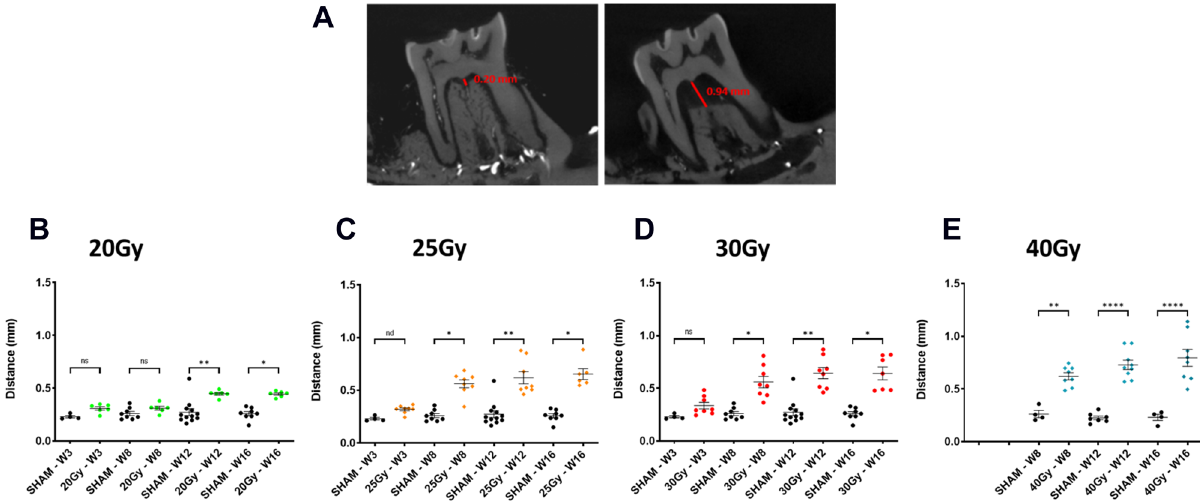
Figure 6. In vivo longitudinal study of distance measurement on 2D images from 3 to 16 W. ( A ) Representative pictures showing the distance measurement between the first molar and the underlying bone in sham (left) and irradiated animals (right). ( B ) Graphic representing localized bone loss for 20 Gy; N = 6 animals ( C ) 25 Gy; N = 7 animals ( D ) 30 Gy; N = 8 animals ( E ) 40 Gy; N = 8 animals compare to Sham N = 4. Statistical analysis: Kruskall Wallis non-parametric test * versus sham.